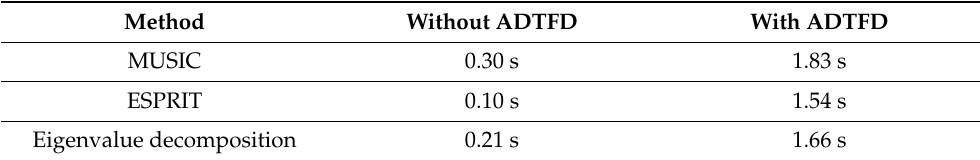
Table 3. Computation time for the DOA estimation